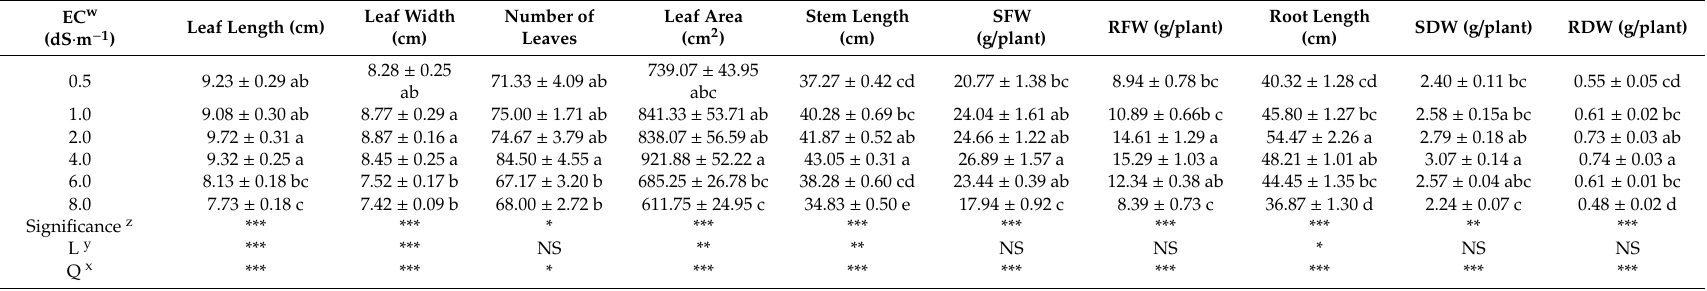
Table 1. Plant growth parameters of Agastache rugosa grown at di ff erent electrical conductivity (EC) treatments (0.5, 1.0, 2.0, 4.0, 6.0, and 8.0 dS · m − 1 ) at 28 days after